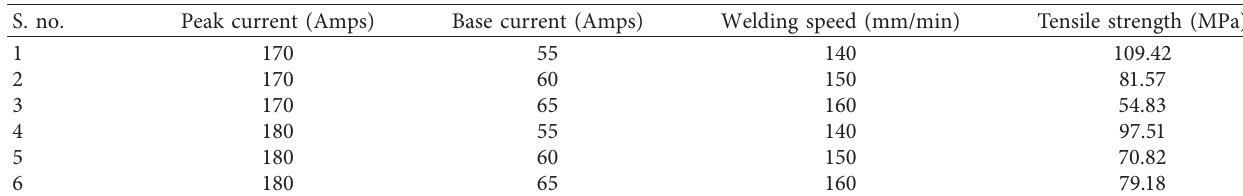
Figure 2: Samples prepared and tested in the tensile test: (a) before testing and (b) after testing. Table 4: Tensile strength of TIG-welded AA8006